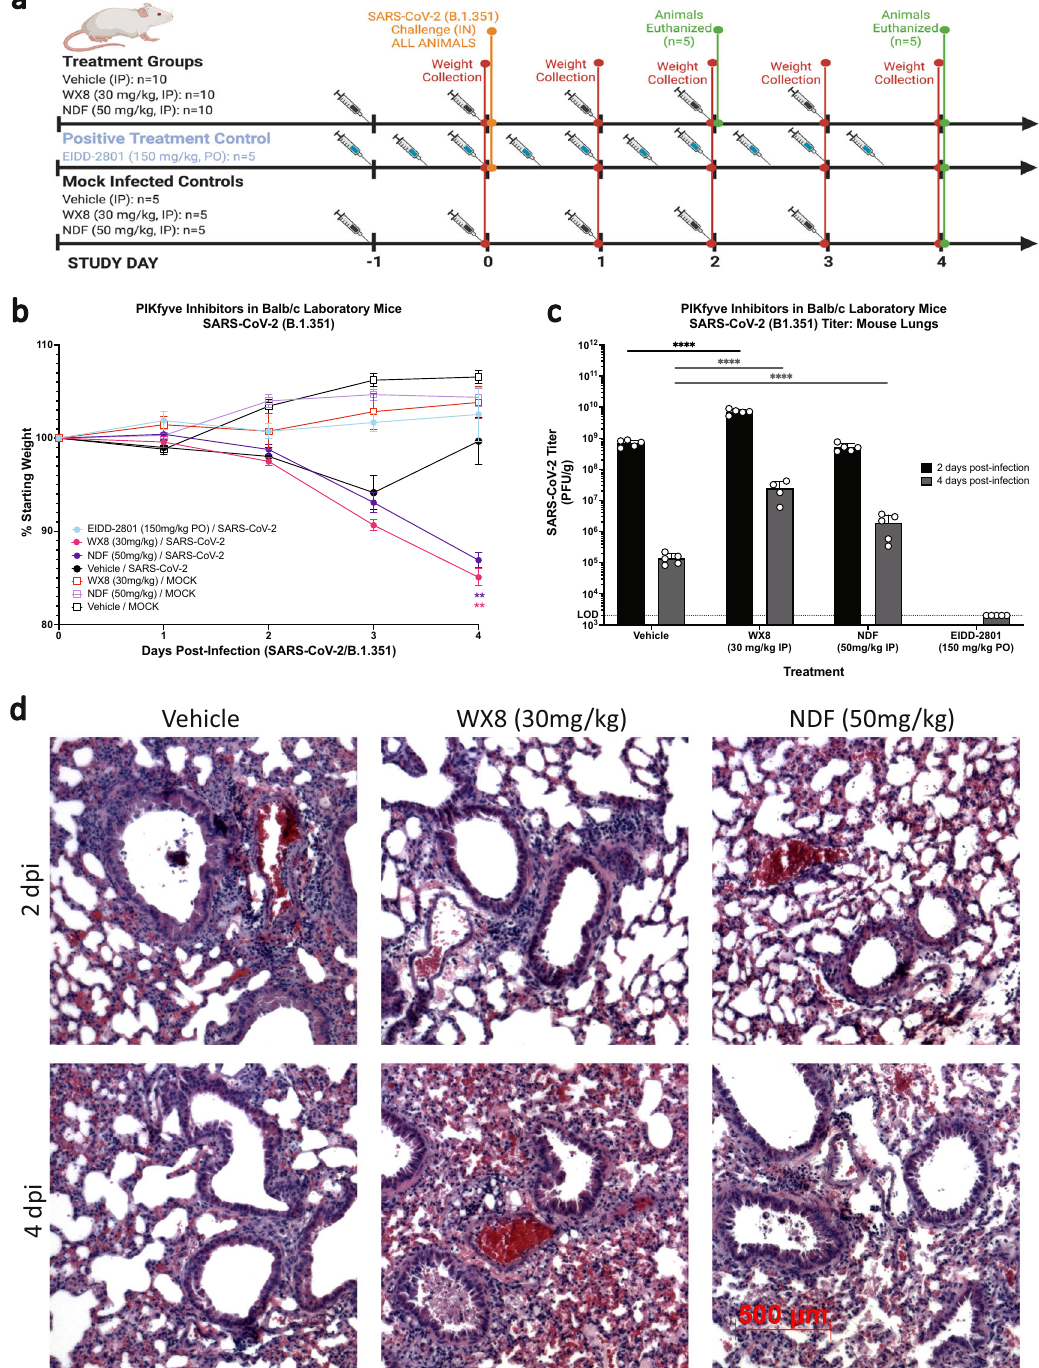
Fig. 2 Pre-exposure prophylactic ef fi cacy of PIKfyve inhibitor treatment against SARS-CoV-2 infection in mice. a Groups of mice were treated intraperitoneally with PIKfyve inhibitors WX8 or NDF once daily beginning 1 day pre-intranasal-challenge with 1 × 10 5 plaque forming units SARS-CoV-2 (B.1.351). EIDD-2801 dosed twice a day was used as a positive treatment control and uninfected treatment controls were included to assess cytotoxicity. Image created using BioRender. b Weight changes were determined for 4 days post-challenge, plotted as the group mean with error bars indicating the ±SD. c Infectious viral loads from lung homogenates at 2 (black) or 4 (gray) days post SARS-CoV-2 challenge. d Lungs were collected at 2- or 4-days post- challenge and stained with hematoxylin and eosin to assess bronchiolar and alveolar damage and immune cell in fi ltration (500- μ m scale bar shown at bottom left, representative for all panels). Mixed-effects analysis was used to compare differences in weight change or viral loads from lung homogenates between infection treatment groups and the vehicle-treated control group; ** p ≤ 0.01, **** p ≤ 0.0001. dpi, days post-infection; PO, oral dosing; IP, intraperitoneal; IN,